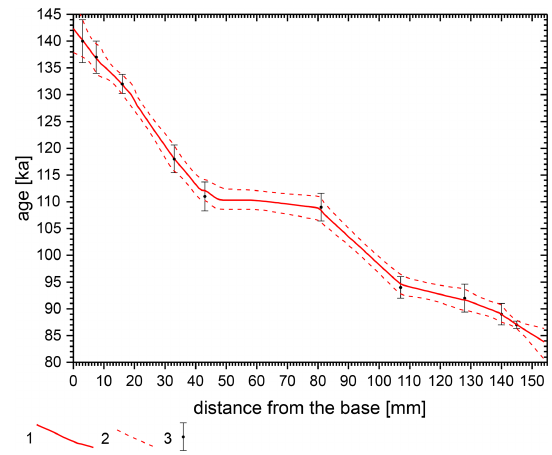
Figure 3. Age–depth model for the JS9 stalagmite. 1 denotes the age–depth model median, 2 denotes the 2 σ confidence band and 3 denotes the U-series ages with 2 σ